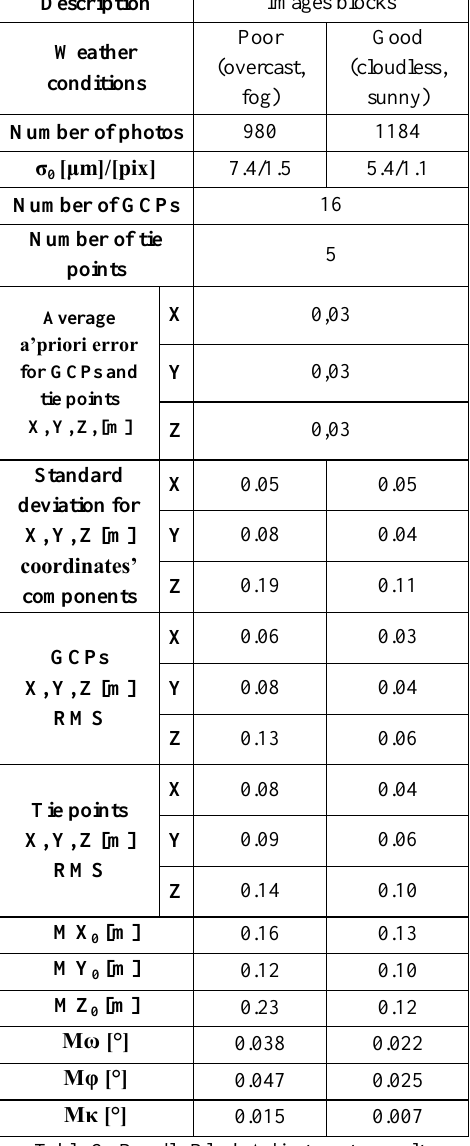
Table 2. Bundle Block Adjustment - results